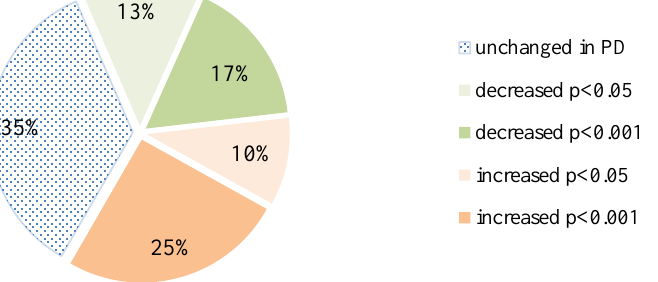
Figure 2. Distribution of the calculated lectin / lectin ratios based on their statistical significance.